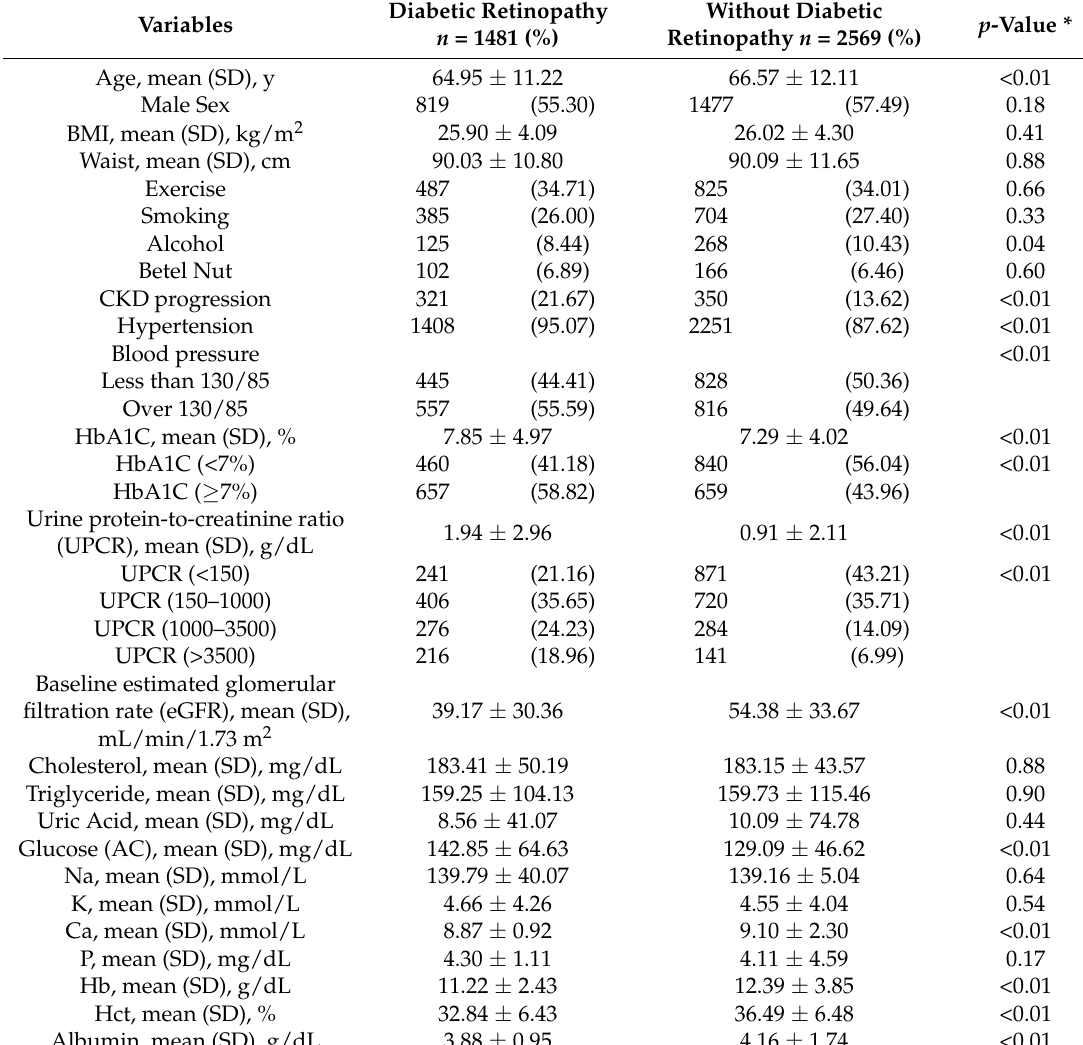
Table 1. Basic characteristics of chronic kidney disease (CKD) patients in the group with diabetic retinopathy (DR) or the group without diabetic retinopathy